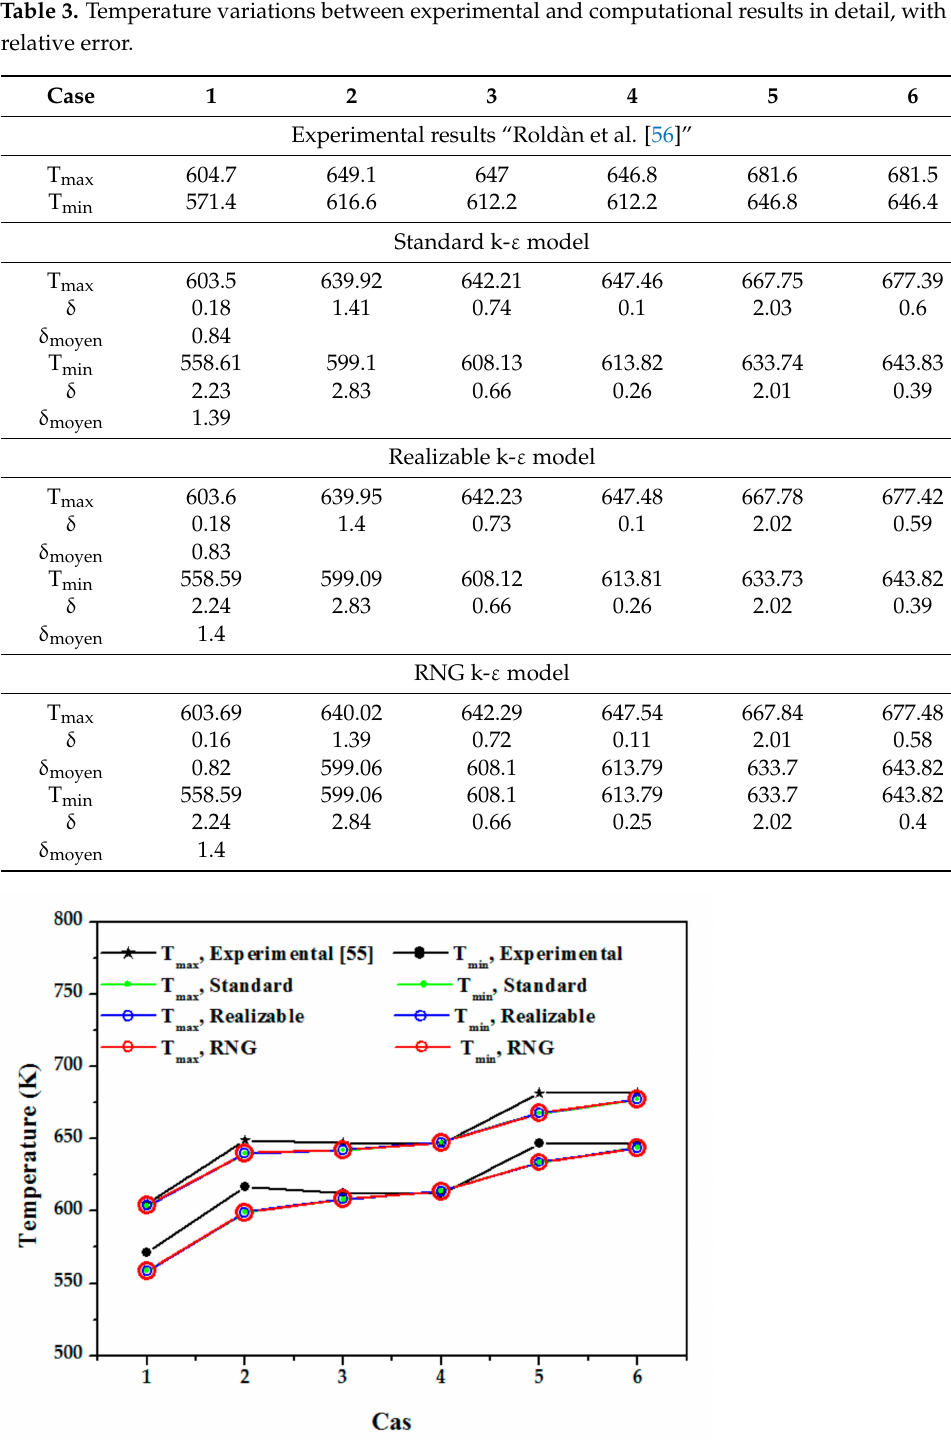
Figure 6. Temperature on outlet surface of tube receiver [56]. Reproduced with permission from [56]. Elsevier,